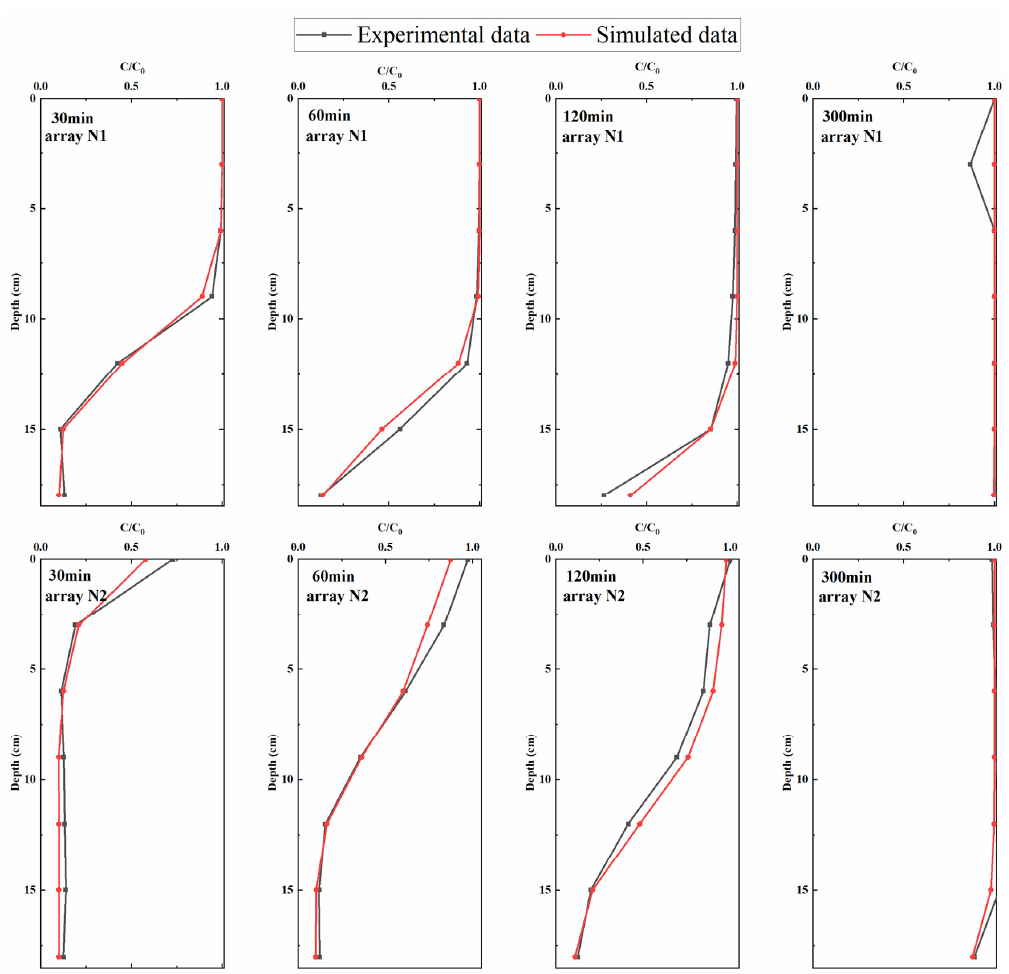
Figure 3. Comparison between the measured (black curves) and simulated (red curves) solute concentrations varying with depth.